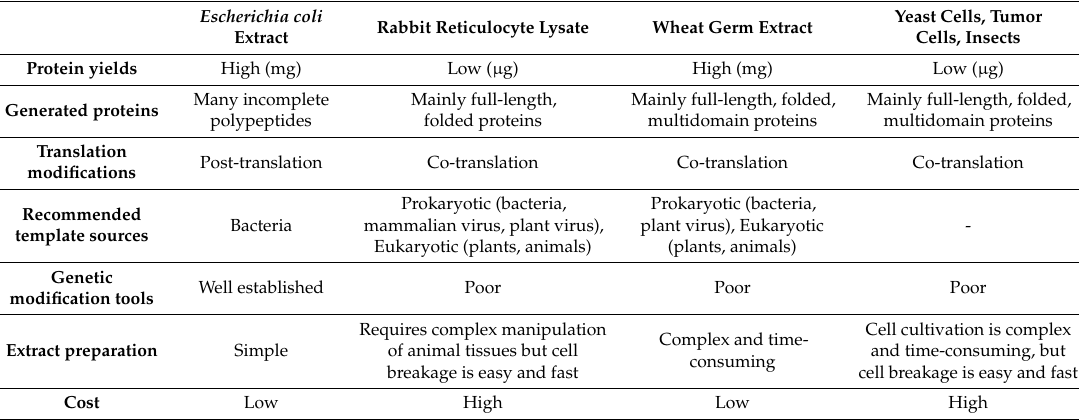
Table 2. Comparison of different cell-free protein expression systems [9,12,17–24].